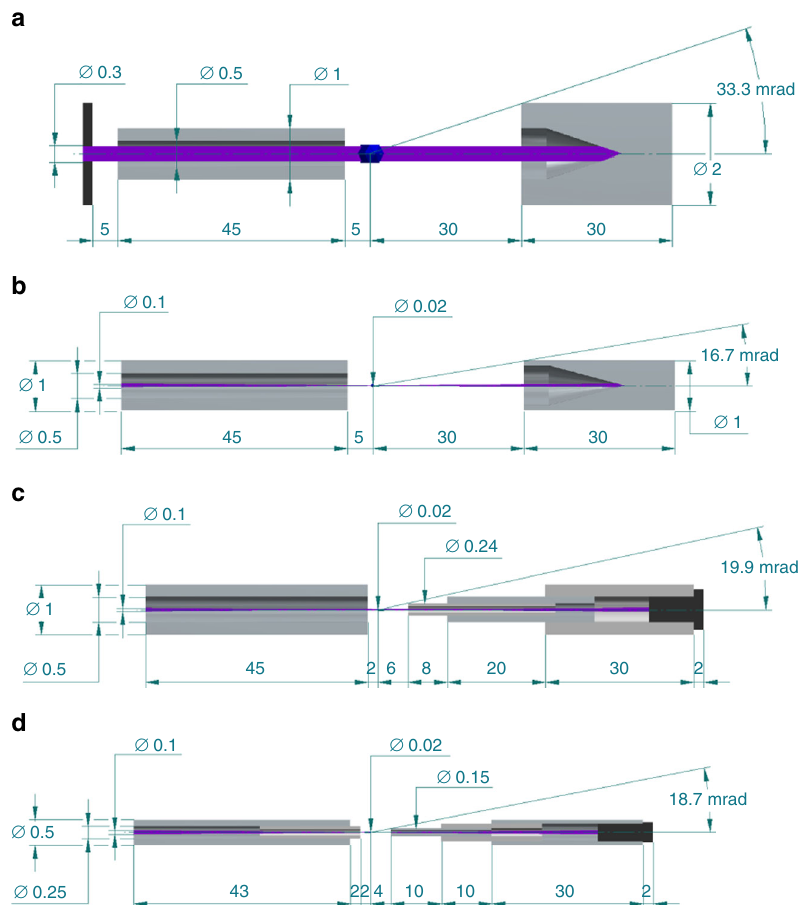
Fig. 8 Evolution of collimator and beamstop designs. a Collimator and beamstop design typically used at protein crystallography beamlines at second generation synchrotron sources. A fraction of a relatively large X-ray beam is selected by using a 0.5 mm inner diameter collimator tube extending 5 mm close to the sample. After interaction with the sample, the direct beam is blocked with a 2 mm outer diameter metal cylinder with a blind hole placed about 30 mm behind the sample. The total path of the direct beam in air is about 35 mm. b Beamstop design currently used at most third generation synchrotron protein microfocus crystallography beamlines where much smaller samples can be investigated. Owing to the signi fi cantly smaller X-ray beam waist, the outer diameter of the beamstop can be one millimeter or less. Placed at a distance of again 30 mm low q-re fl ections can be now recorded up to a half opening angle of 16.7 mrad. The total path of the X-ray beam in air is again 35 mm. c Low background collimator and beamstop concept used for the present work. The path of the direct beam in air is reduced to 8 mm. X-ray photons scattered by air within the capillary are absorbed by the capillary walls. Compared to previous beamstop concepts a , b the path of the direct X-ray beam in air is shortened to 8 mm — reducing the background scattering level by a factor of about 4. At the end of the capillary the direct beam is blocked with a solid absorber. d Future beamstop concept: already 4 mm behind the sample the direct beam is fully enclosed by a 0.25 mm outer and 0.15 mm inner diameter metal capillary. The direct beam can be either blocked with a solid absorber or the tube can be extended through a hole in the detector and then blocked behind (favorable for XFEL applications). For data collection at cryogenic temperatures, collimator and post-sample beam-capillary would require heating, to prevent ice deposition caused by the